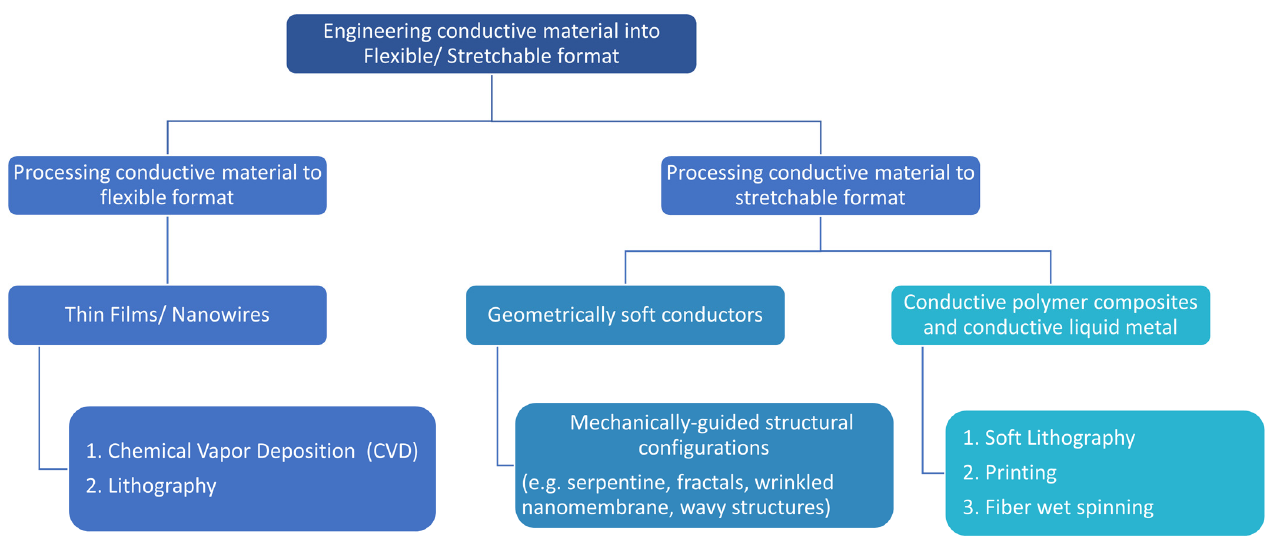
Figure 5. A chart summarizing the engineering of conductive material into flexible and stretchable format.